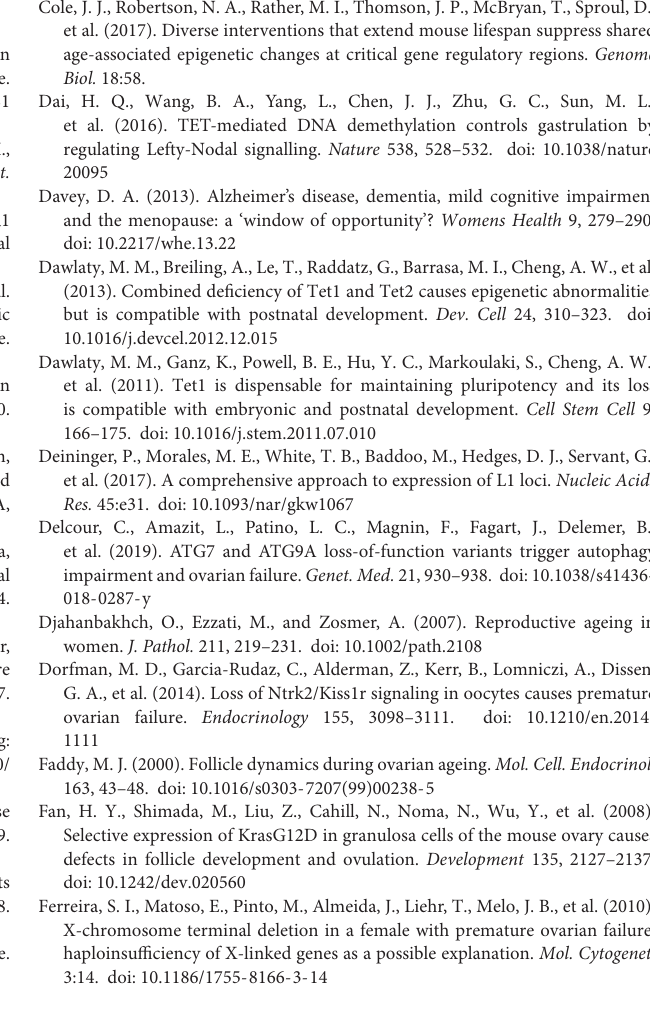
Supplementary Table 2 . (B) Table summarizing the litter size and Mendelian ratio of Tet1 − / − mice. (C) Tet1 mRNA expression level in ovaries of young mice by qPCR analysis. (D) Tet1 protein expression level in E3.5 blastocysts by immunofluorescence. Scale bar, 10 µ m. (E) Representative images of primordial follicles from young WT mouse ovary. (F) Representative images of primordial follicles stained with 5 hmC antibody. Dashed line indicates the primordial oocyte. Scale bar, 10 µ m. Bottom panel, Relative 5 hmC level in primordial oocytes from young mice. n = 21 oocytes counted for each group. Data represents mean ± SEM. *** P < 0.001. Supplementary Figure 2 | Distribution of differentially expressed genes across chromosomes. (A) Scatter plot illustrating the chromosomal distribution of differential genes Between young WT and Tet1 − / − oocytes. (B) Protein-protein interactome network analysis using Metascape (http://metascape.org/gp/index.html#) showing the potential interaction of Fmr1, Hnrnpu and Pabpc1 and with other proteins. Supplementary Figure 3 | Coverage of Smart-seq2 of oocytes and comparison with transcriptome data on PGCs from Yamaguchi et al., 2012. (A) Boxplot displaying number of genes sequenced in oocytes. (B) Venn plot showing the overlapped, downregulated genes between oocytes based on our data and PGCs from Yamaguchi et al., 2012. (C) Venn plot showing the overlapped, downregulated genes between oocytes and PGCss associated with DMRs, based on Yamaguchi et al.,